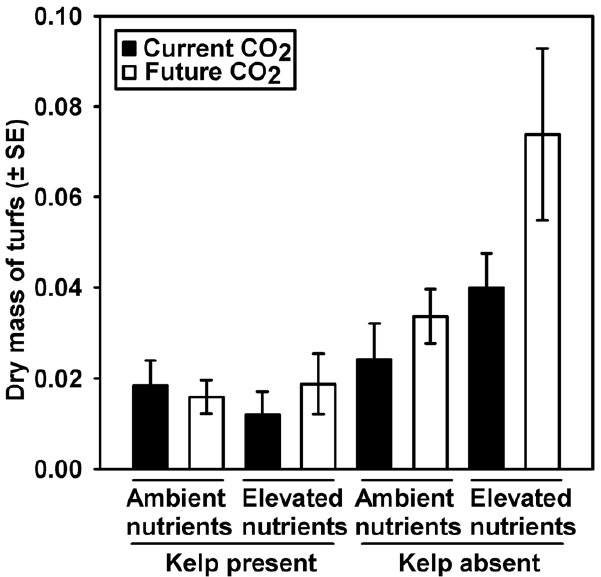
Figure 3. The dry mass of turf-forming algae on natural rock substrate that were transplanted from ambient conditions (as defined in Figure 1) to different combinations of Kelp (present v. absent), Nutrients (ambient v. elevated) and CO 2 (current v. future).